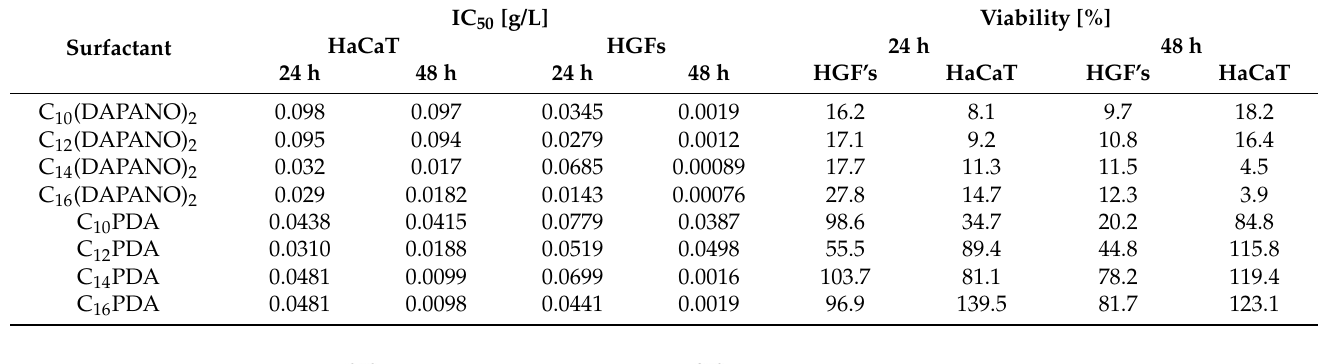
Table 2. Evaluation IC 50 for normal human keratinocytes (HaCaT) and primary fibroblasts (HGFs) and the percentage of viability concentration after 24 and 48 h incubation with surfactants.